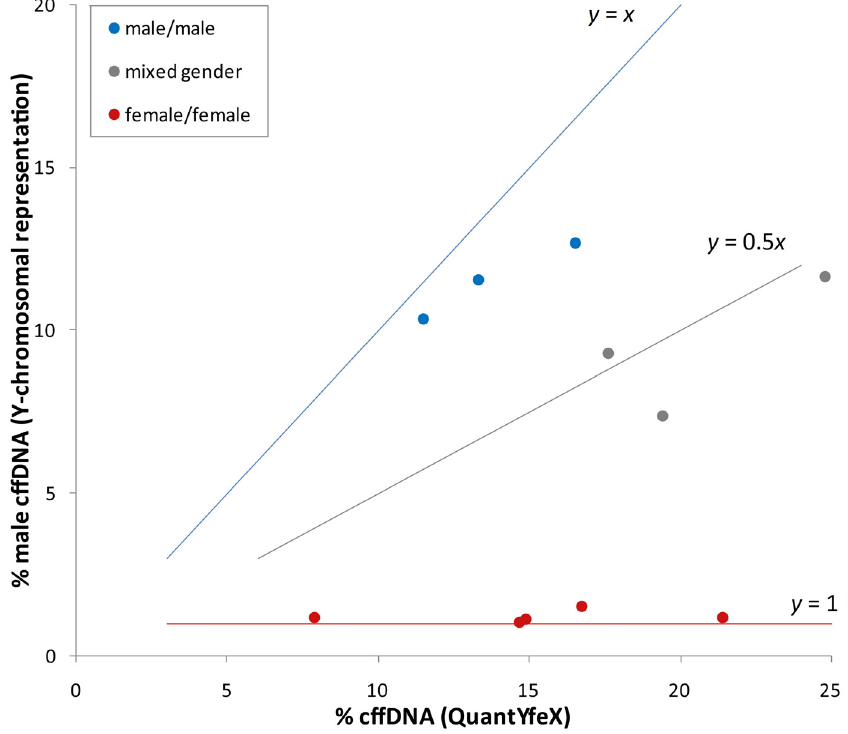
Figure 1. Correlation of the amount of male specific DNA to the fetal fraction measured by QuantYfeX for study cases with known fetal